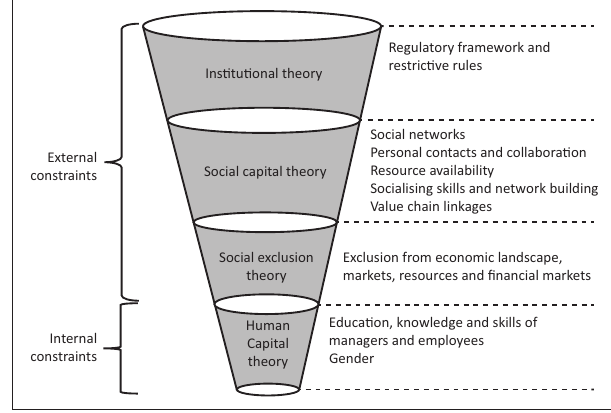
FIGURE 1: Key factors hindering the growth of informal enterprises.